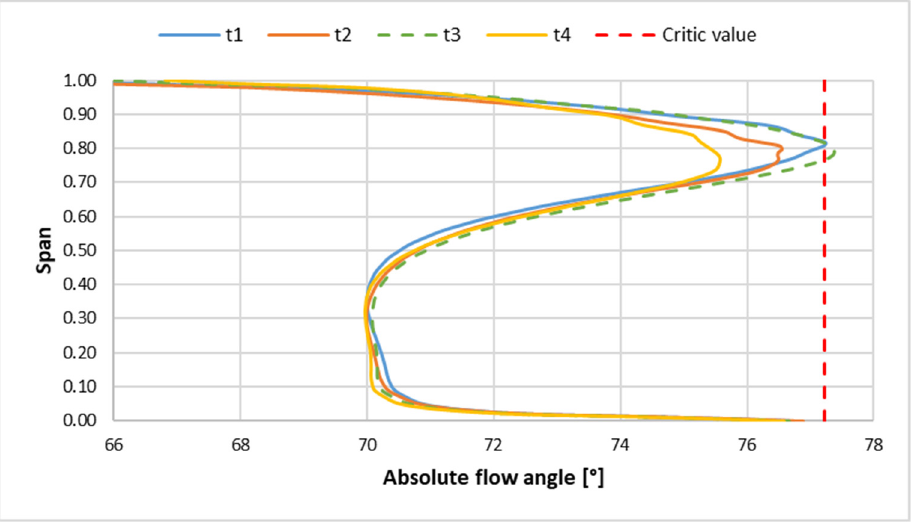
Figure 20. Hub-to-shroud distributions of the absolute flow angle at the diffuser inlet obtained with the fully 3D unsteady model with ported shroud at the condition OP3, for several instants.